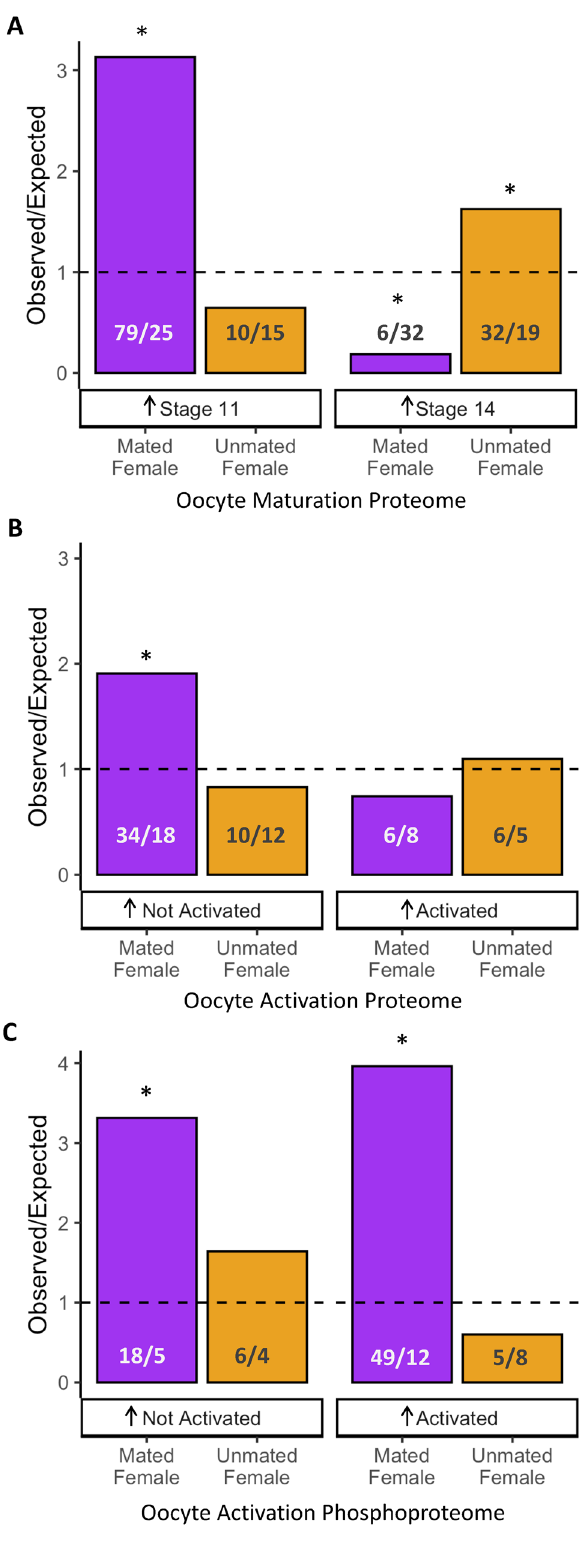
Figure 5. Comparison to protein changes that occur during oocyte maturation and activation. Bar plots of the observed versus expected protein overlap between protein abundances differences in oocytes from mated (purple) and unmated females (orange) with ( A ) proteomic changes during oocyte maturation, ( B ) proteomic changes during oocyte activation and ( C ) proteomic changes in phosphoproteins during oocyte activation. The number of observed versus expected (rounded to the nearest whole number) proteins is indicated. Significance is indicated by asterisks (*p <